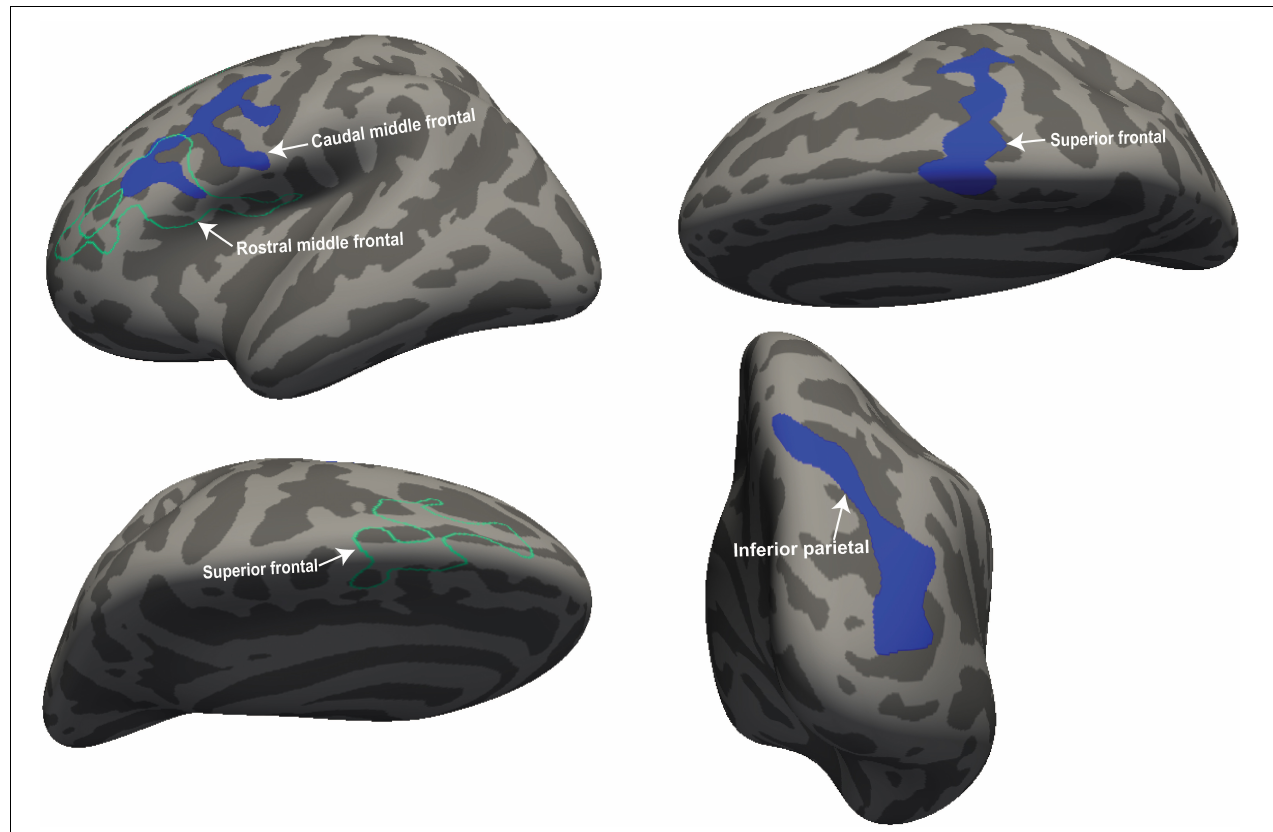
FIGURE 5 | For ME/CFS and HC, a significant cluster from interaction-with-group regressions with “Resp” and “Ment_all.” The volume cluster of caudal middle frontal and superior frontal were observed in the left and right hemisphere and the thickness cluster of superior frontal when cortical volume and thickness regressed with “Resp.” The volume cluster of the inferior parietal lobe was detected at the right hemisphere when regressed with “Ment_all.” The volume is represented with filled blue color whereas thickness (right hemisphere) is represented by unfilled green color. Significant volume and thickness clusters were overlaid on the inflated brain (left and right hemisphere) available in the